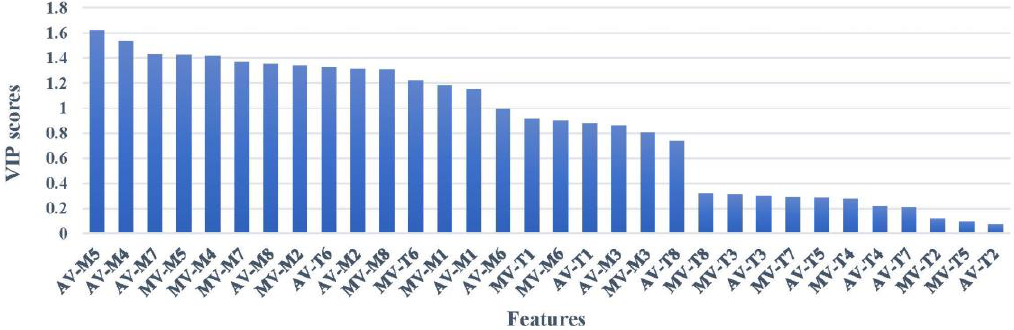
Figure 8. Relative variable importance based on calculated VIP.